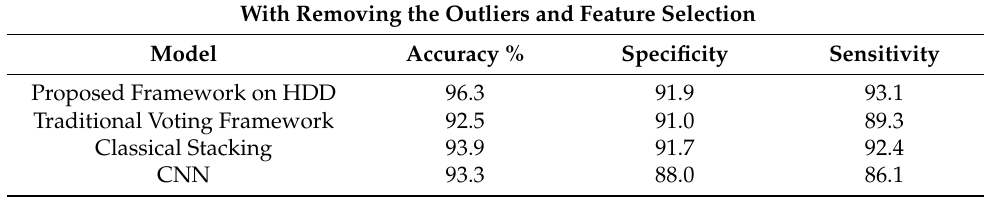
Table 4. Results for the proposed framework on